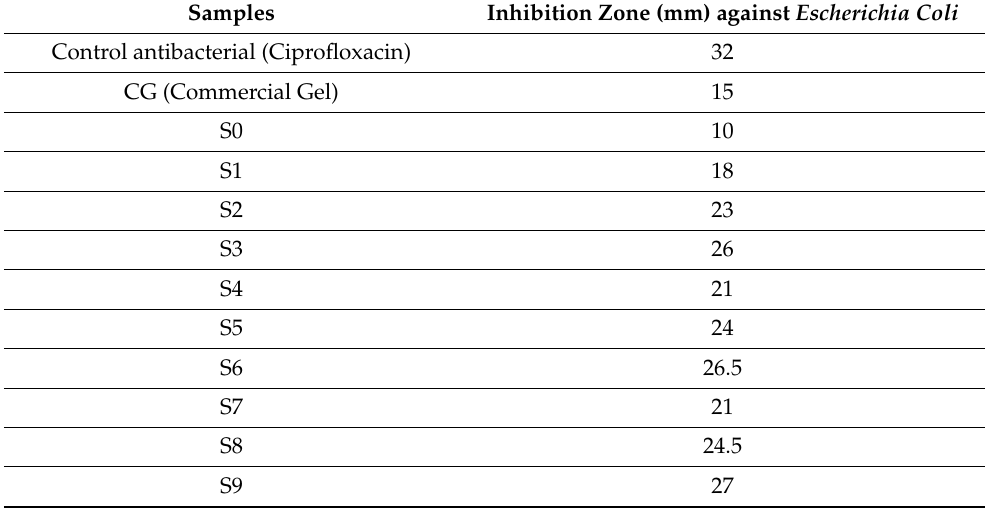
Table 2. Conductivity values of prepared ultrasound gel formulations and commercial ultrasound gel.